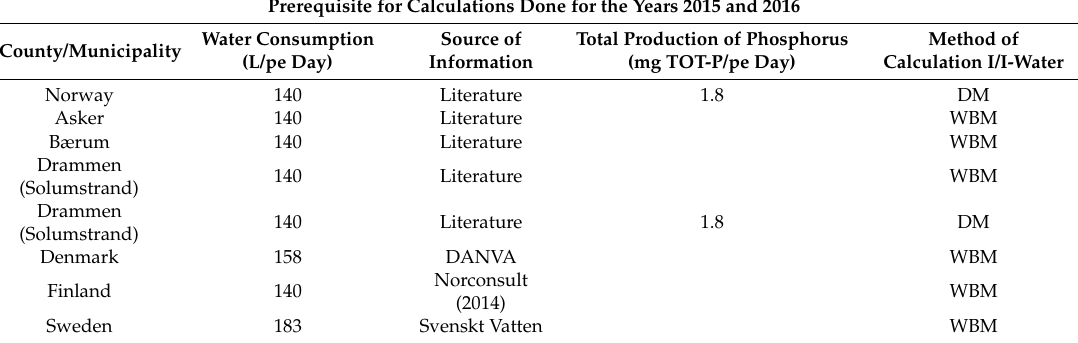
Table 3. Summary of values used in the calculation of I/I-water for the year 2015/2016 concerning water consumption, phosphorus production, and the calculation